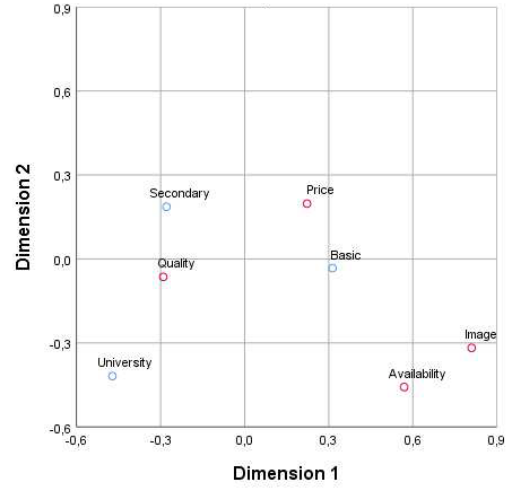
Figure 2. Correspondence map (Education/Motivation)